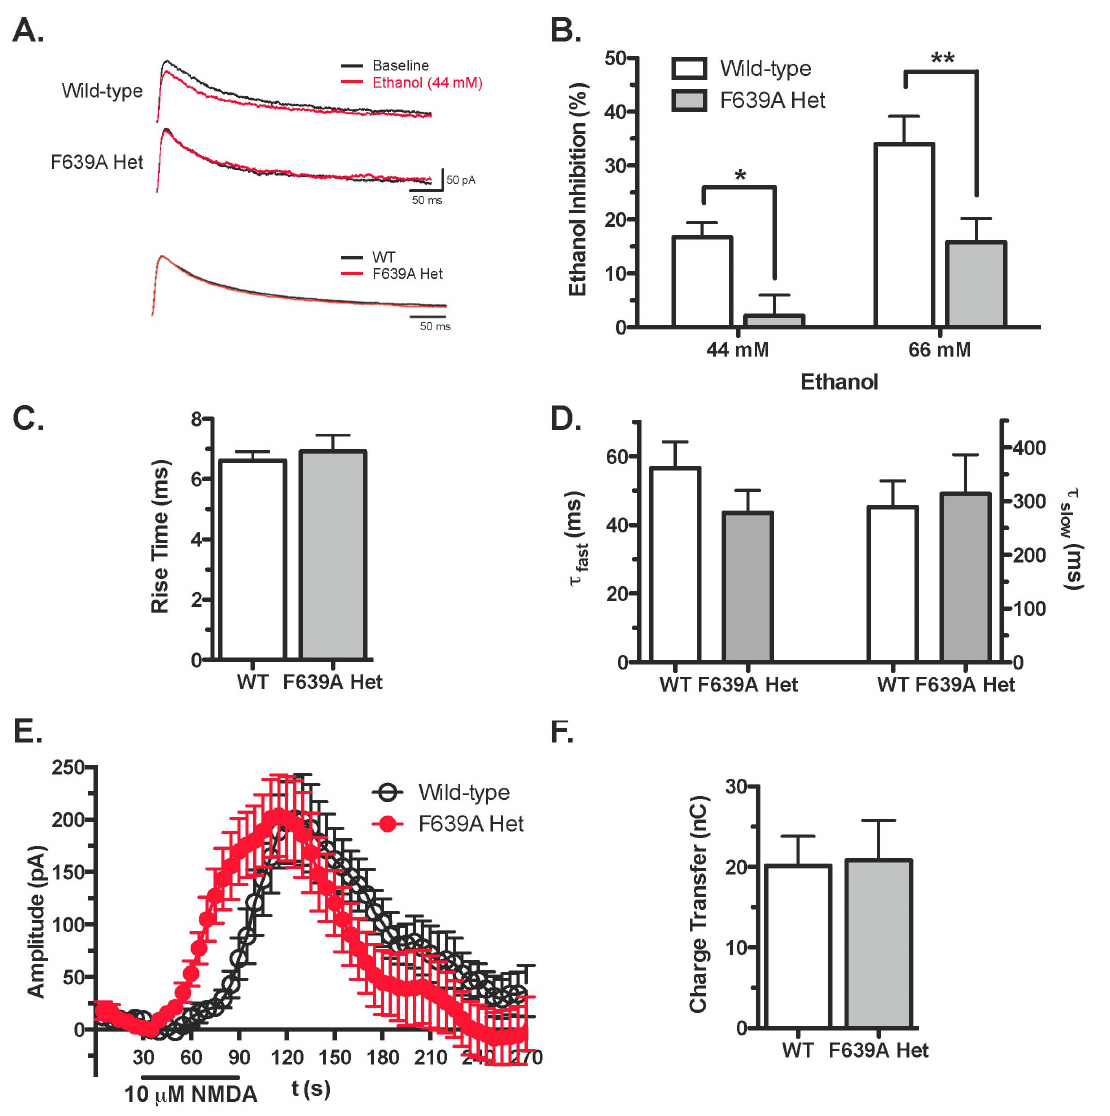
Figure 2. GluN1(F639A) mutation alters ethanol inhibition of NMDA-mediated currents in adult mice. ( A ), Top: Sample traces of electrically evoked NMDA EPSCs in mPFC neurons from wild-type and F639A Het mice at baseline ( black ) and during exposure to 44 mM ethanol ( red ). Bottom: Control NMDA EPSCs from wild-type and F639A Het mice normalized by amplitude. ( B ), Summary of ethanol inhibition of NMDA- mediated EPSCs in neurons from wild-type (44 mM, n=10; 66 mM, n=7) and F639A Het mice (44 mM, n=9; 66 mM, n=10). Data are percent of control (mean 6 SEM). Symbol ( * ): value significantly different from wild-type ( * p , 0.05; ** p , 0.01; two-way ANOVA, Bonferroni’s post hoc test). ( C ), Rise time (mean 6 SEM) of NMDA-mediated EPSCs in wild-type (n=7) and F639A Het mice (n=9). ( D ), Mean values ( 6 SEM) for fast (left) and slow (right) decay time constants of NMDA-mediated EPSCs from wild-type (fast, n=7; slow, n=9) and F639A Hets (fast, n=7; slow, n=9). ( E ), Change in holding current of mPFC neurons from wild-type and F639A Het mice before, during, and after bath application of 5 m M NMDA (n=7–8 for each group). Values are mean 6 SEM. ( F ), Total charge transfer through NMDA receptors in wild-type and F639A Het mice (n=7–8 for each group). Values are mean 6